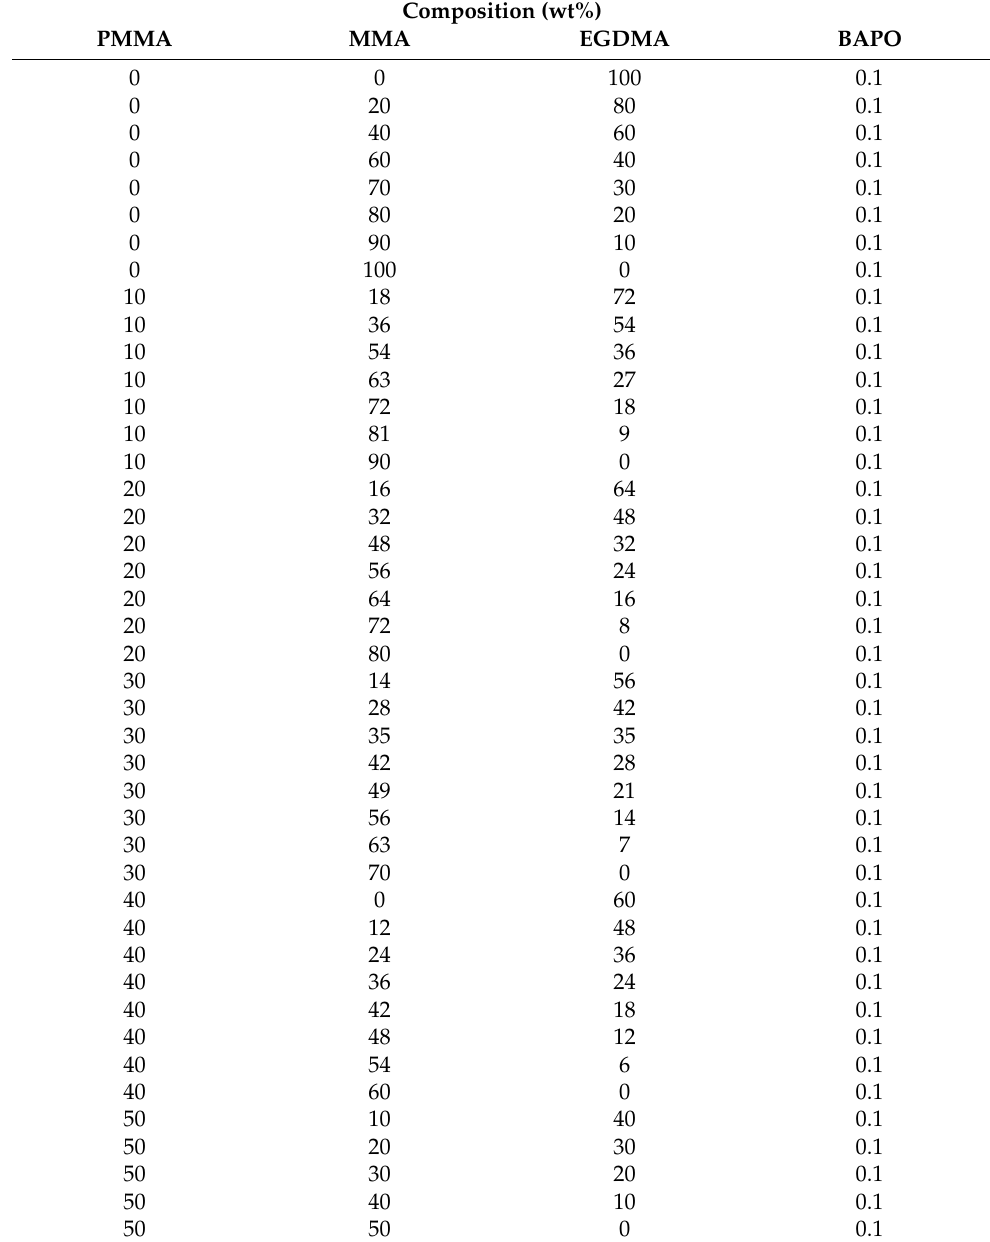
Table 3. Compositions of the prepared PMMA-based resins. The sample name was abbreviated